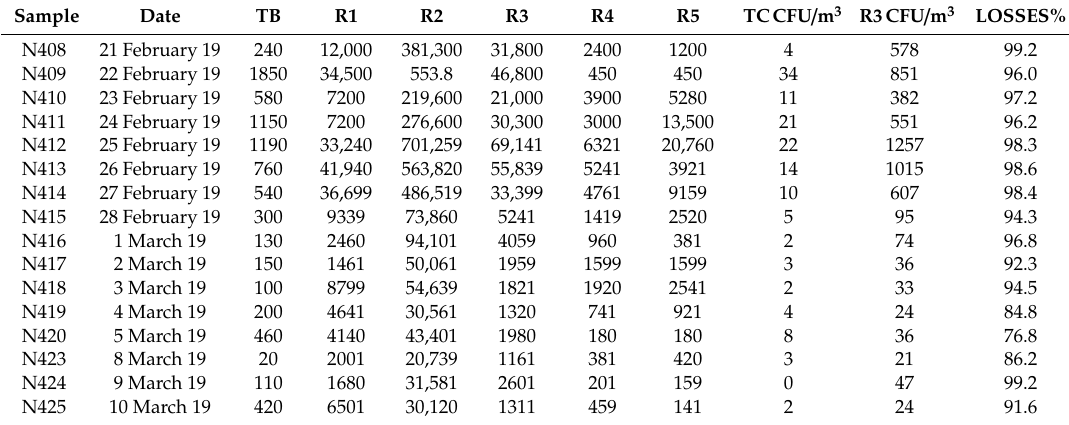
Table A1. Total Bacteria counted in the 3 mL sample from the extraction of the atmospheric samples where TB represents the Total Bacteria, R1, R2, R3, R4, R5 represent the di ff erent populations gates